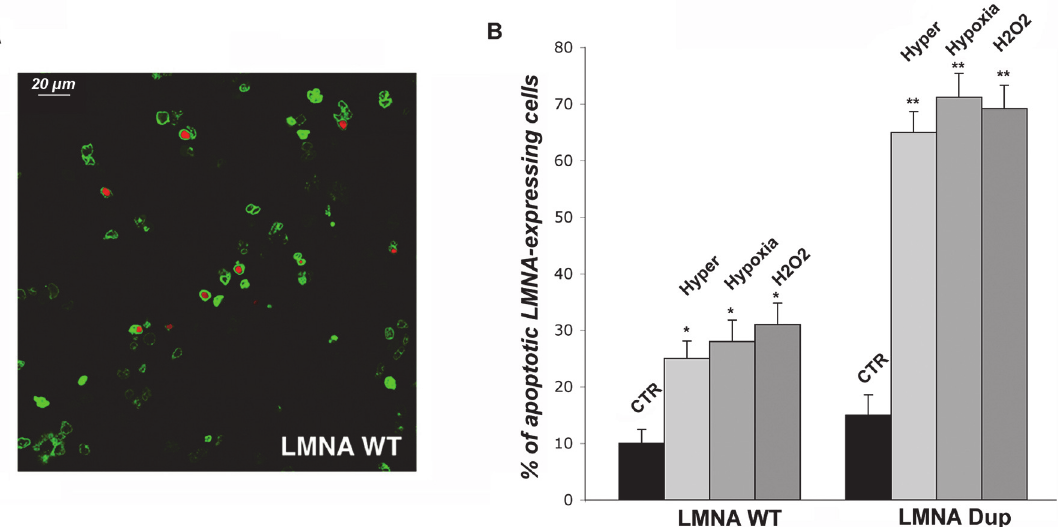
Fig 6. Apoptosis assay in LMNA transfected HL-1 cells. (A) Representative XY confocal planar projections of LMNA transfected cells (green) labelled with EthD-1 (red) in control conditions are depicted. (B) Quantitative analysis of apoptotic cells in control and under hyperosmotic (Hyper), hypoxic (Hypoxia), and oxidative (H 2 O 2 ) conditions. Data are reported as % of apoptotic cells (double-labelled cells) in overall LMNA-expressing cells (green labelled cells). Statistical analysis was performed on 3 independent experiments and significance calculated by Student ’ s T-test for unpaired samples. * P < 0.0002 is relative to CTR vs. stressing conditions in WT LMNA expressing cells and ** P < 0.0001 is relative to CTR vs. stressing conditions in DUP LMNA expressing